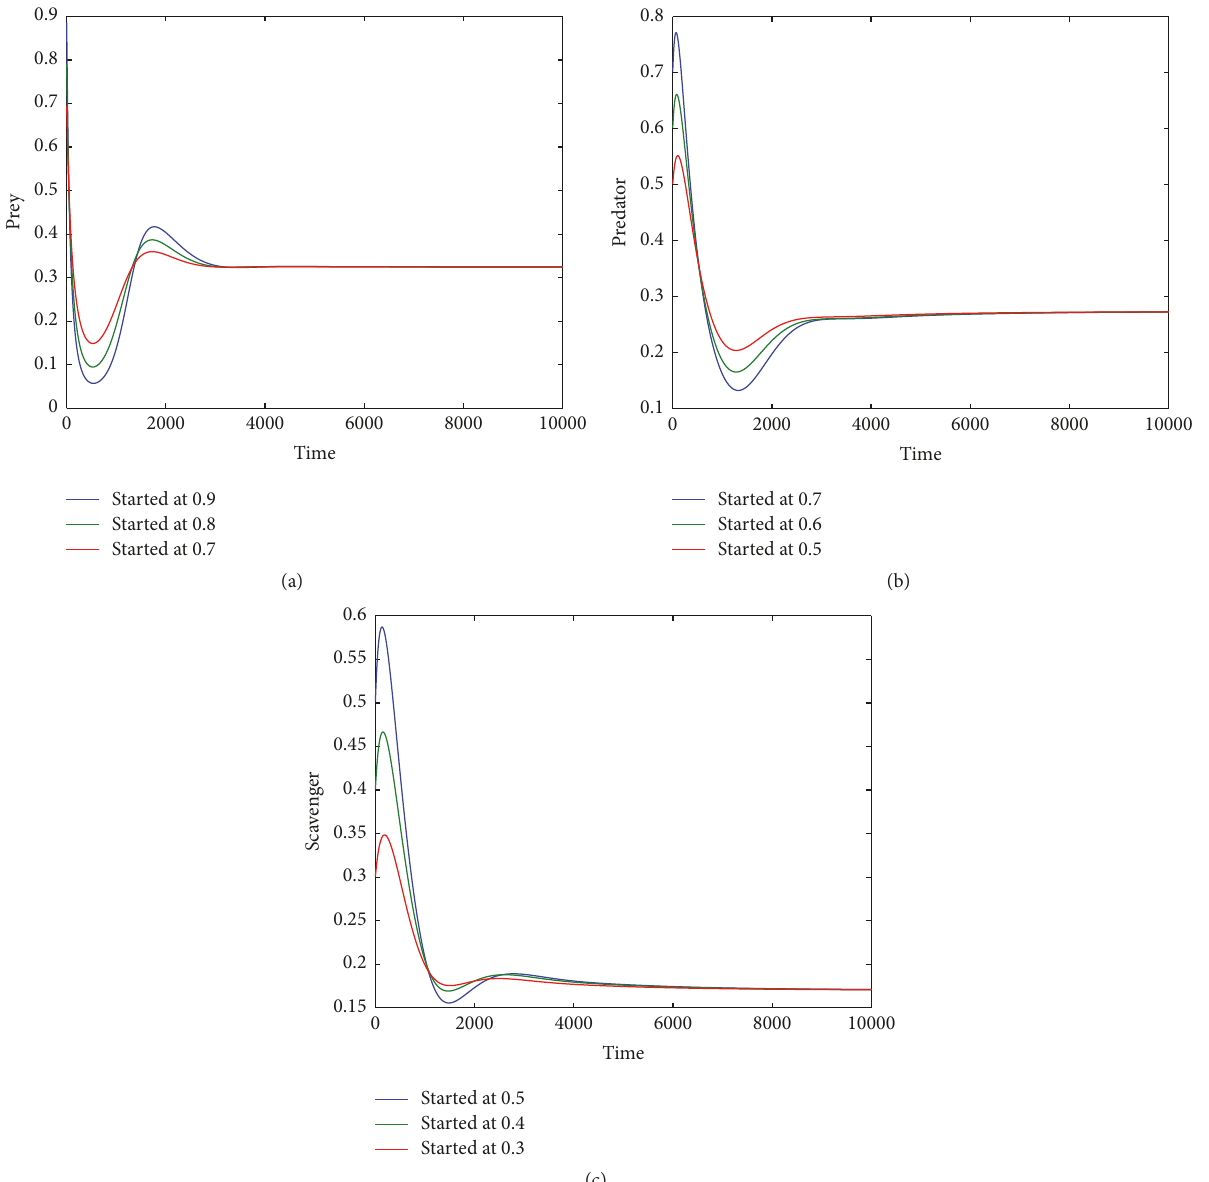
Figure 2: Time series of the attractor in Figure 1. (a) Prey as a function of time. (b) Predator as a function of time. (c) Scavenger as a function of